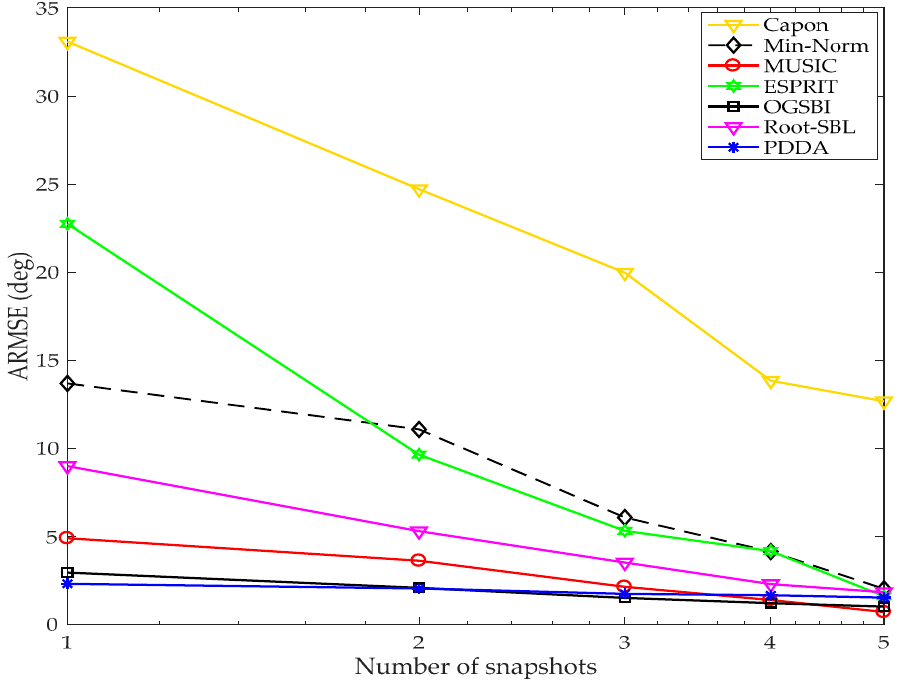
Figure 7. Average root mean square error (ARMSE) vs. number of snapshots with signal to noise ratio (SNR) = 10 dB, M = 8, D = 2, 1000 Monto Carlo simulations for each N .